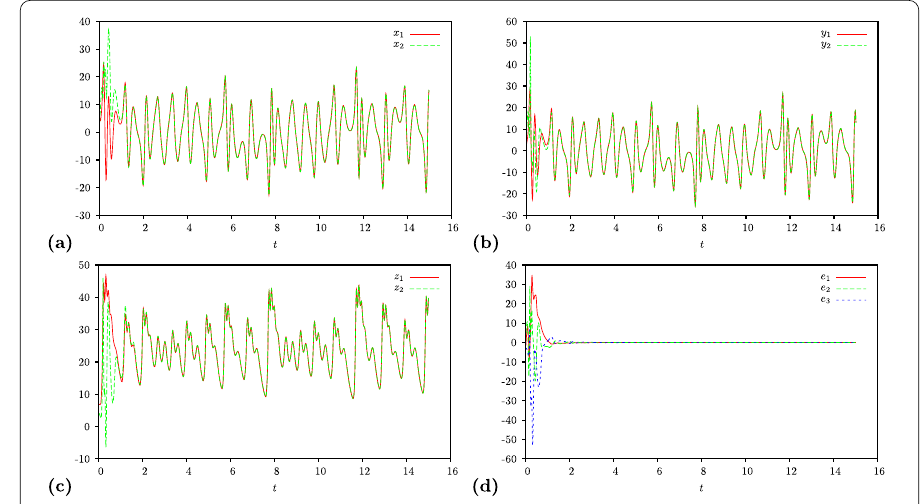
Figure 3 State trajectories of drive system (36) and response system (37): ( a ) signals x 1 and x 2 ; ( b ) signals y 1 and y 2 ; ( c ) signals z 1 and z 2 ; ( d ) evolution of the errors e 1 , e 2 , e 3 with respect to time t